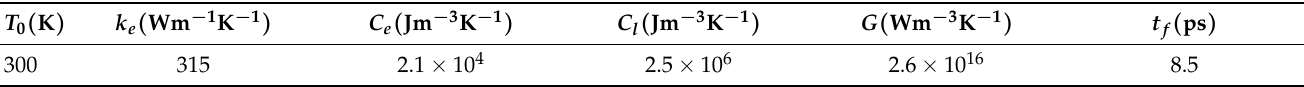
Table 7. Thermal properties of gold